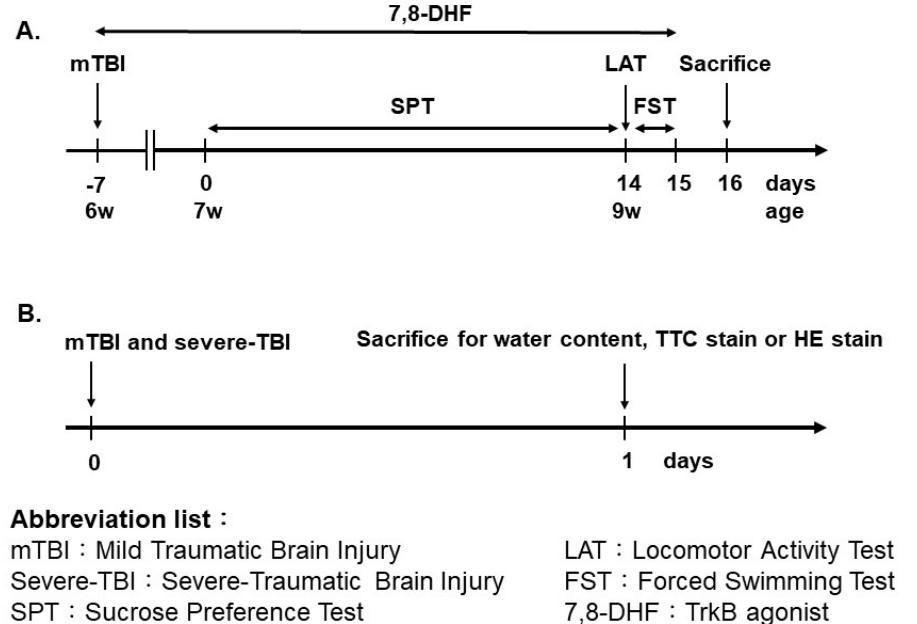
Figure 1. Timeline for the experimental procedure. ( A ) General experimental procedure for evaluating the depression-like behavior in mTBI treated animals. ( B ) The experimental procedure for evaluating the brain damage in mTBI and severe-TBI treated animals.